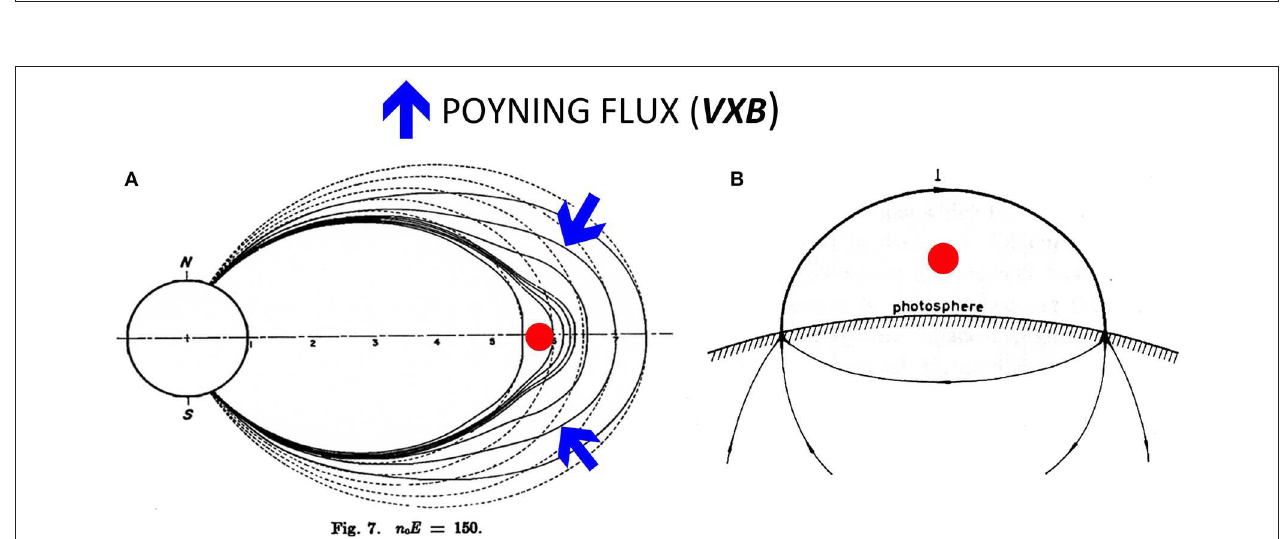
FIGURE 8 | The location where the power is accumulated. (A) The inner magnetosphere is inflated (red dot) as the power flows into there. The Poynting flux is also shown (blue arrow) (Akasofu). (B) For flares, one of the possibilities for the location is a loop current along the dark filament (red dot) (Alfven, 1950; a red dot is added). This loop current is produced by the photospheric dynamo and is discussed in this section ( Figure 11 ).